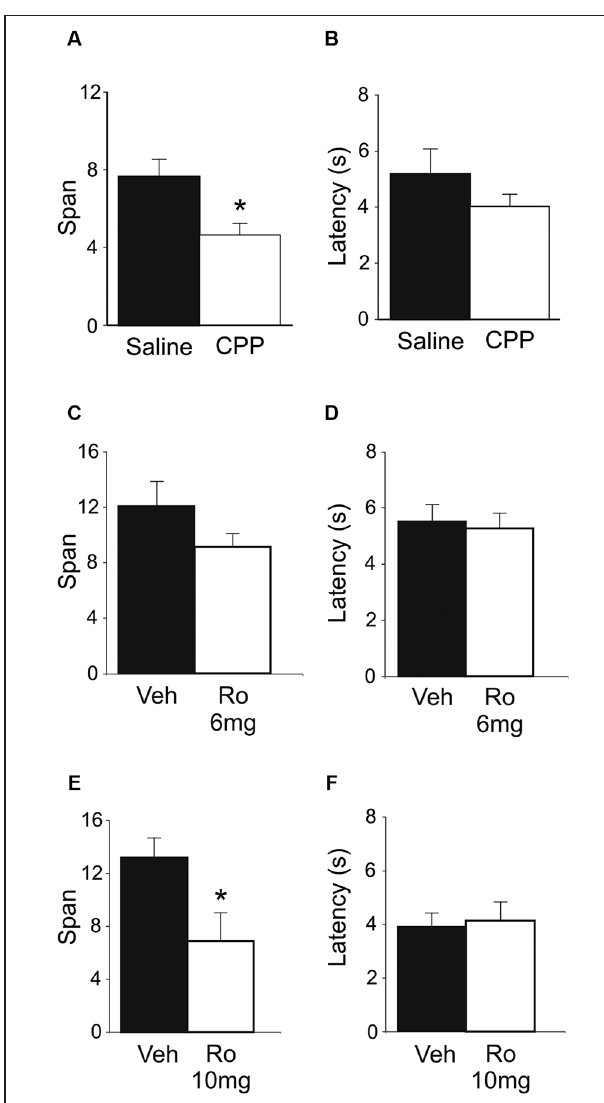
FIGURE 3 | OST performance following infusions of either Ro 25-6981 or CNQX into mPFC ( n = 7). (A) Mean spans of the rats following vehicle (Veh) or Ro 25-6981 infusions into mPFC. (B) The mean latency of the rats to begin digging in a bowl for the treatments in A. (C) Mean spans for the rats following treatment with either Veh or CNQX into the mPFC. (D) The mean latency for the rats to begin digging in a bowl (Veh or CNQX; mPFC infusion). (E) Infusion sites in the mPFC. Numbers refer to the anterior-posterior location of the plates relative to bregma. * Refers to a significant difference between treatments ( p <